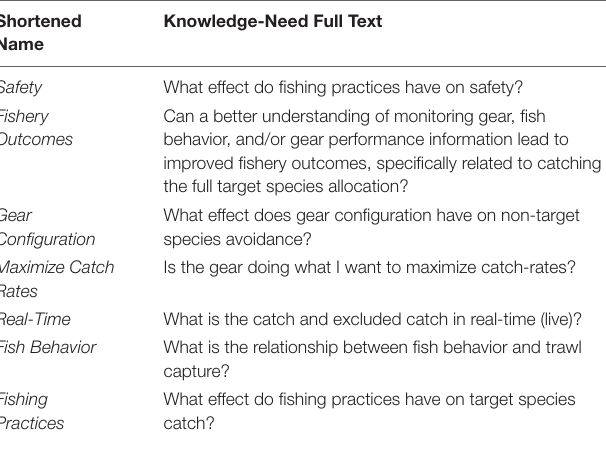
TABLE 3 | Finalized knowledge-needs for the in-person workshop and corresponding shortened names used throughout this